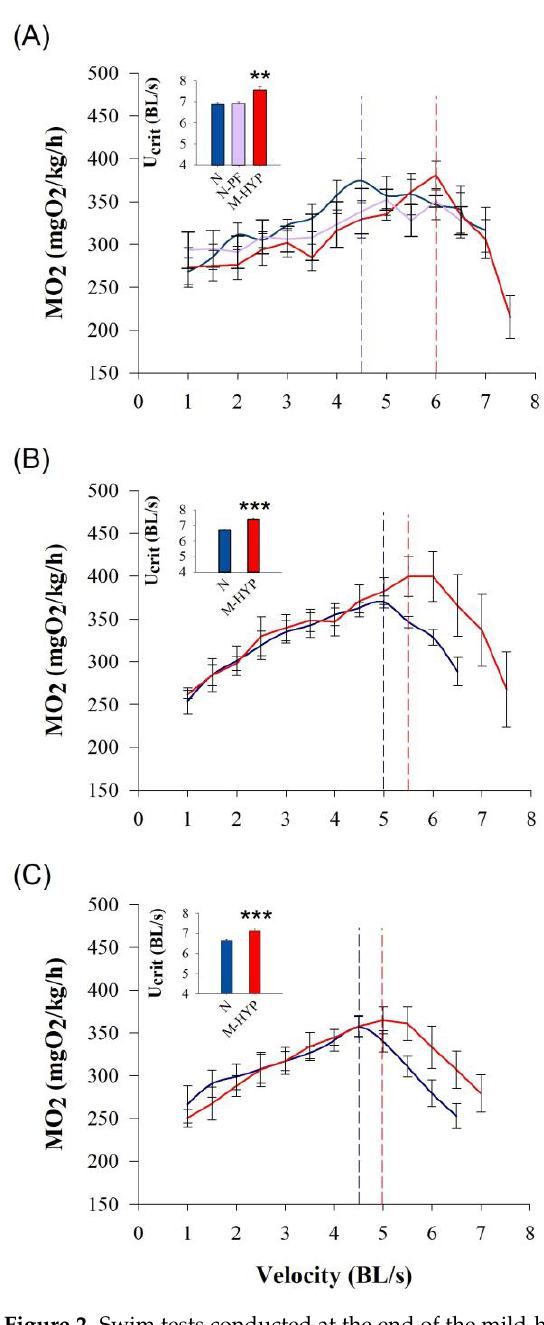
Figure 2. Swim tests conducted at the end of the mild-hypoxia conditioning period (t 45H ) ( A ), after a 1-week normoxia recovery period (t +7N ) ( B ), and after a 3-week normoxia recovery period (t +21N ) ( C ). Mild-hypoxia fish (M-HYP) are in red, pair-fed fish (N-PF) are in violet, and normoxic fish (N) are in blue. Values showing oxygen consumption (MO 2 ), maximum metabolic Rate (MMR), and U crit are the mean ± SEM of 4 – 6 fish. Asterisks indicate statistically significant differences among groups (one-way ANOVA, SNK test, ** p < 0.01; *** p < 0.001).